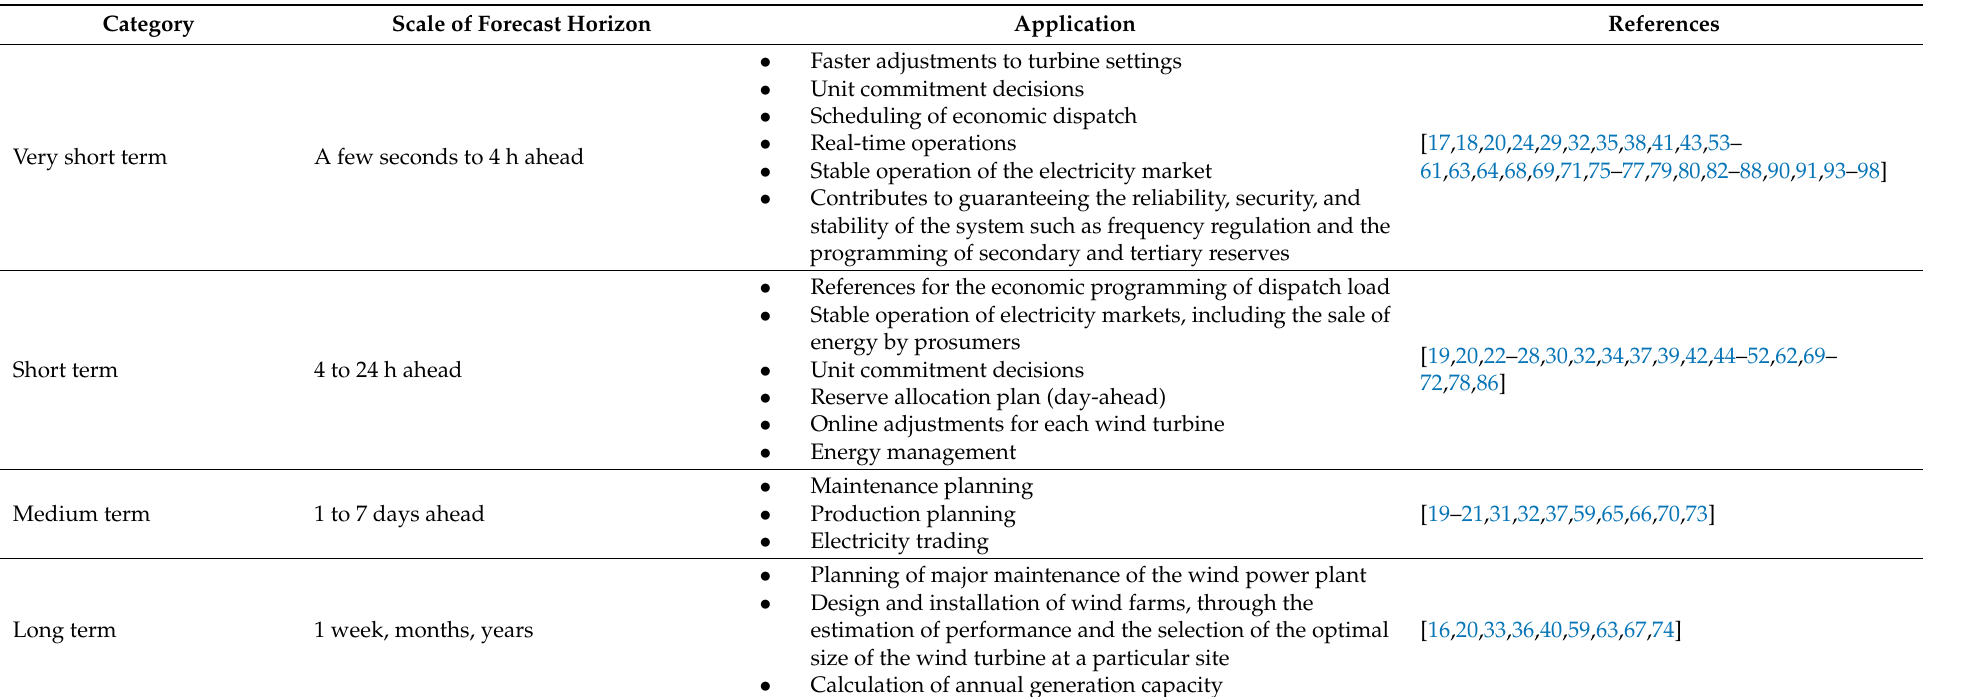
Table 2. Applications of wind forecast models by time